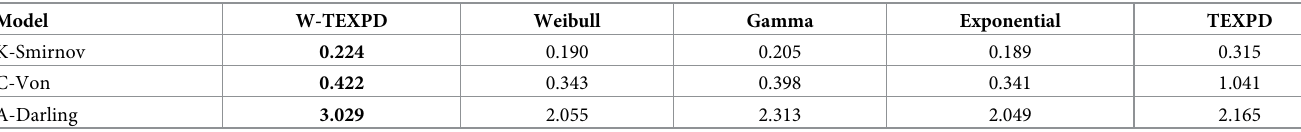
Table 16. Goodness of fit statistic of 40 losses due to wind-related catastrophes.